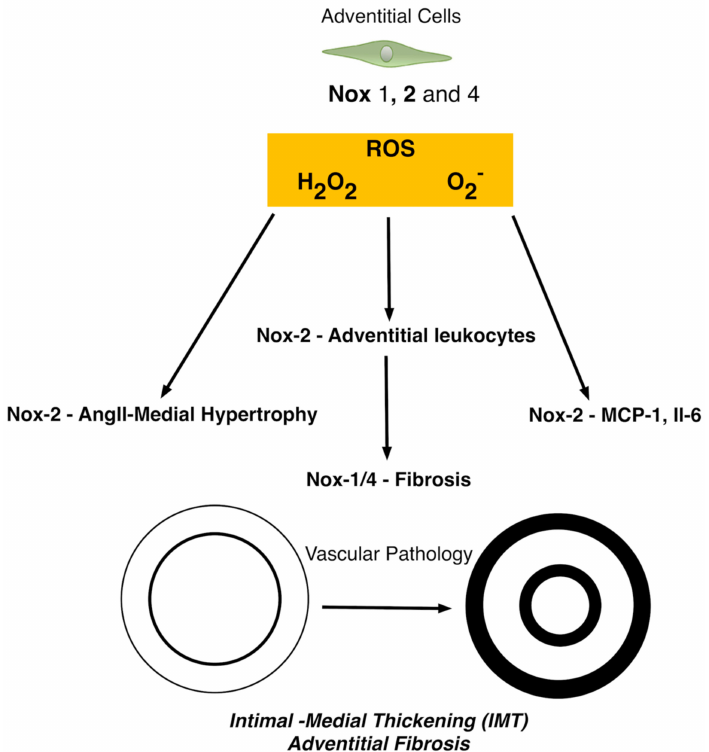
Figure 4. Simplified schematic of common forms of Nox enzymes in adventitial cells. Nox2 and p22phox are predominant in the adventitia of hypertensive vessels and promote the secretion of monocyte chemoattractant protein-1 (MCP-1) and interleukin 6 (IL-6). Nox1 and Nox4 with Nox4-derived H 2 O 2 considered protective are also present